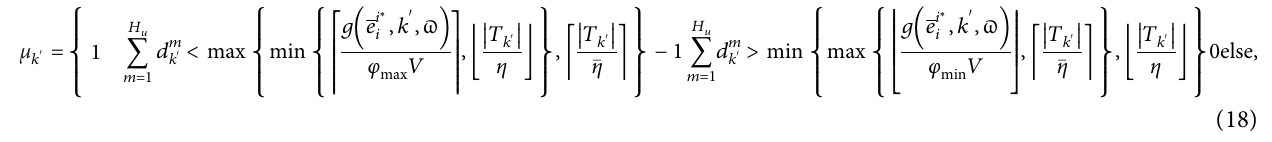
Figure 4: Single genome